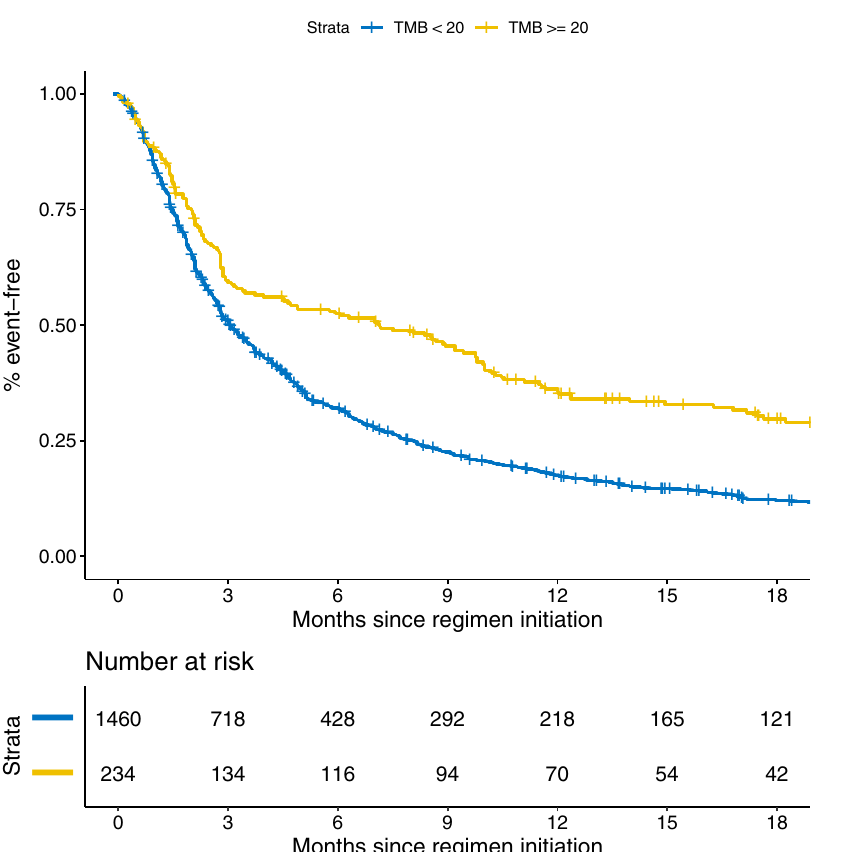
Fig. 1 Example of a clinico-genomic analysis based on outcomes ascertained using natural language processing models: Association between TMB and progression-free survival after initation of immunotherapy. High tumor mutational burden de fi ned as > = 20 mutations per megabase. Results in this fi gure represent unadjusted Kaplan-Meier curves. Events were recorded using the “ PFS-I-and-M ” endpoint, de fi ned as the earlier of death, or the time by which both a medical oncologist note and an imaging report had described cancer progression/worsening. Progression/worsening was de fi ned using natural language processing models applied to imaging reports and medical oncologist notes. Survival curves were not adjusted for left truncation, since progression events were possible prior to genomic testing and cohort